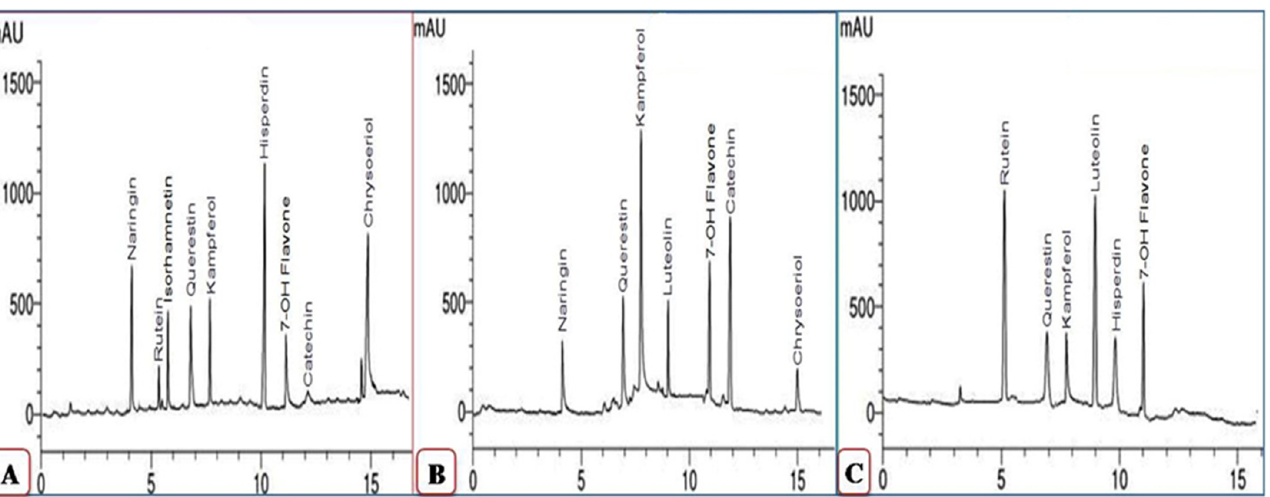
9 of 16 Figure 5. Comparison between the detected phenolic compounds and their concentration ( μ g/mL) in the ethanolic extract of the squash plants in mock-inoculated plants and CMV-inoculated plants